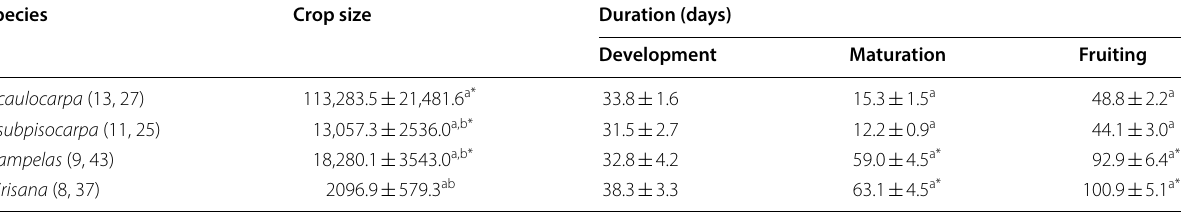
Fig size and internal composition The syconium size differed among the four figs (ANOVA, F (3, 37) 170.04, p < 0.001) and also between any two = species in paired comparisons (Tukey’s HSD, all p val- ues < 0.05). Ficus irisana topped among the four species, and was followed by F. subpisocarpa , and then smaller F. ampelas and F. caulocarpa (Table 3). By controlling fig size as a covariate, the fig breeding system appeared to affect seediness, the pulp-seed ratio, and water con- tent of syconia (MANCOVA, V 1.38, F (9, 108) 10.22, = = p < 0.001). Dioecious figs were higher in seediness ( F. ampelas ) and water contents ( F. ampelas and F. irisana ), but lower in pulp-seed ratios ( F. ampelas and F. irisana ; Table 3). Across breeding systems, fig size also affected interspecific differences in certain fig traits ( V 0.39, F (3, =